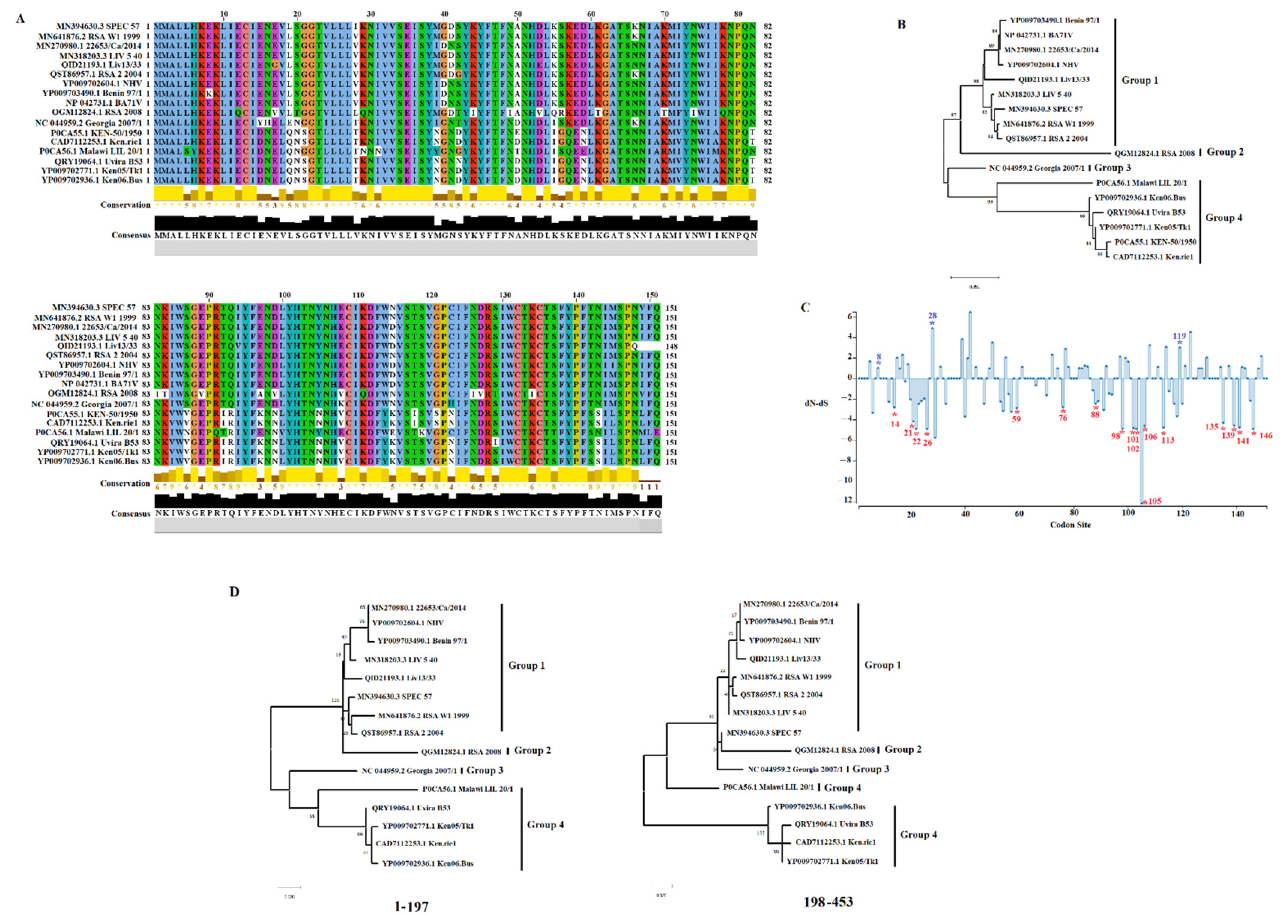
Figure 1. Evaluation of A151R protein across ASFV isolates. ( A ) Amino acid alignment representing the diversity of A151R protein of ASFV in the field. Residues in white spots represent changes between amino acids with different charges. Conservation plot scores reflect the nature of the change in specific sites, with high scores associated with changes in similar biological properties. Alignment was produced using the software Jalview version 2.11.1.4. ( B ) Phylogenetic analysis representing the diversity of A151R protein of ASFV in the field. Based on the cluster distribution, isolates were categorized into five groups. Numbers above internal branches represent bootstrap values (1000 repetitions). ( C ) The graphic represents the dN (rate of evolution at non-synonymous sites), dS (rate of evolution at synonymous sites), and ratio (dN-dS) at specific codon sites in the A151R gene of ASFV. Blue and red asterisks represent codon sites evolving under diversifying and purifying selection, respectively. Analyses were conducted using the evolutionary algorithms FEL and MEME using cutoff values of p = 0.1. ( D ) Phylogenetic analysis showing the topology incongruence produced by different segments where the single breakpoint at nucleotide 197 was detected by GARD. Phylogenetic analysis was conducted with the maximum likelihood method, using the general time reversible